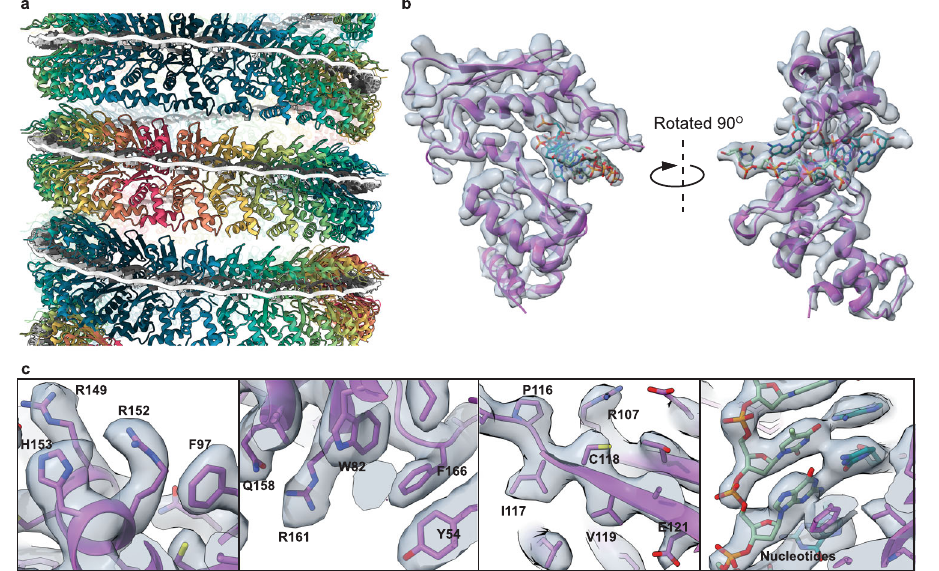
Fig. 2 | Red β 177 and DNA structure. a The ribbon structure of the Red β 177 helix showing the interaction between protein and DNA (black and white) in a planar conformation. b The cryo-EM map of a single Red β 177 monomer(gray)bound to